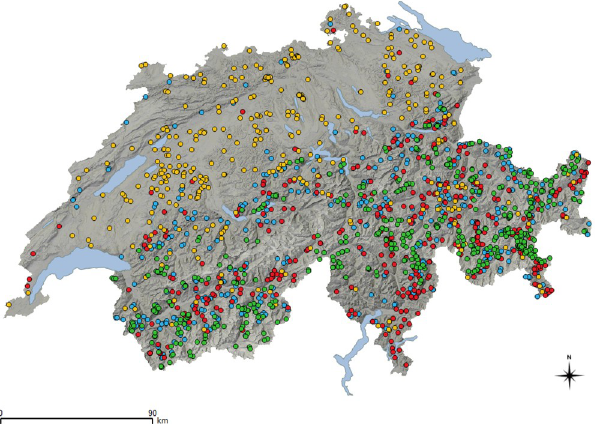
Fig 1. Map of Switzerland showing the distribution of the sampled wild animals. Shades of grey illustrate the mountainous shape. Lakes are in blue. Colored dots correspond to wild ungulates of different species: Yellow: roe deer; Red: red deer; Blue: chamois; and Green: ibex.